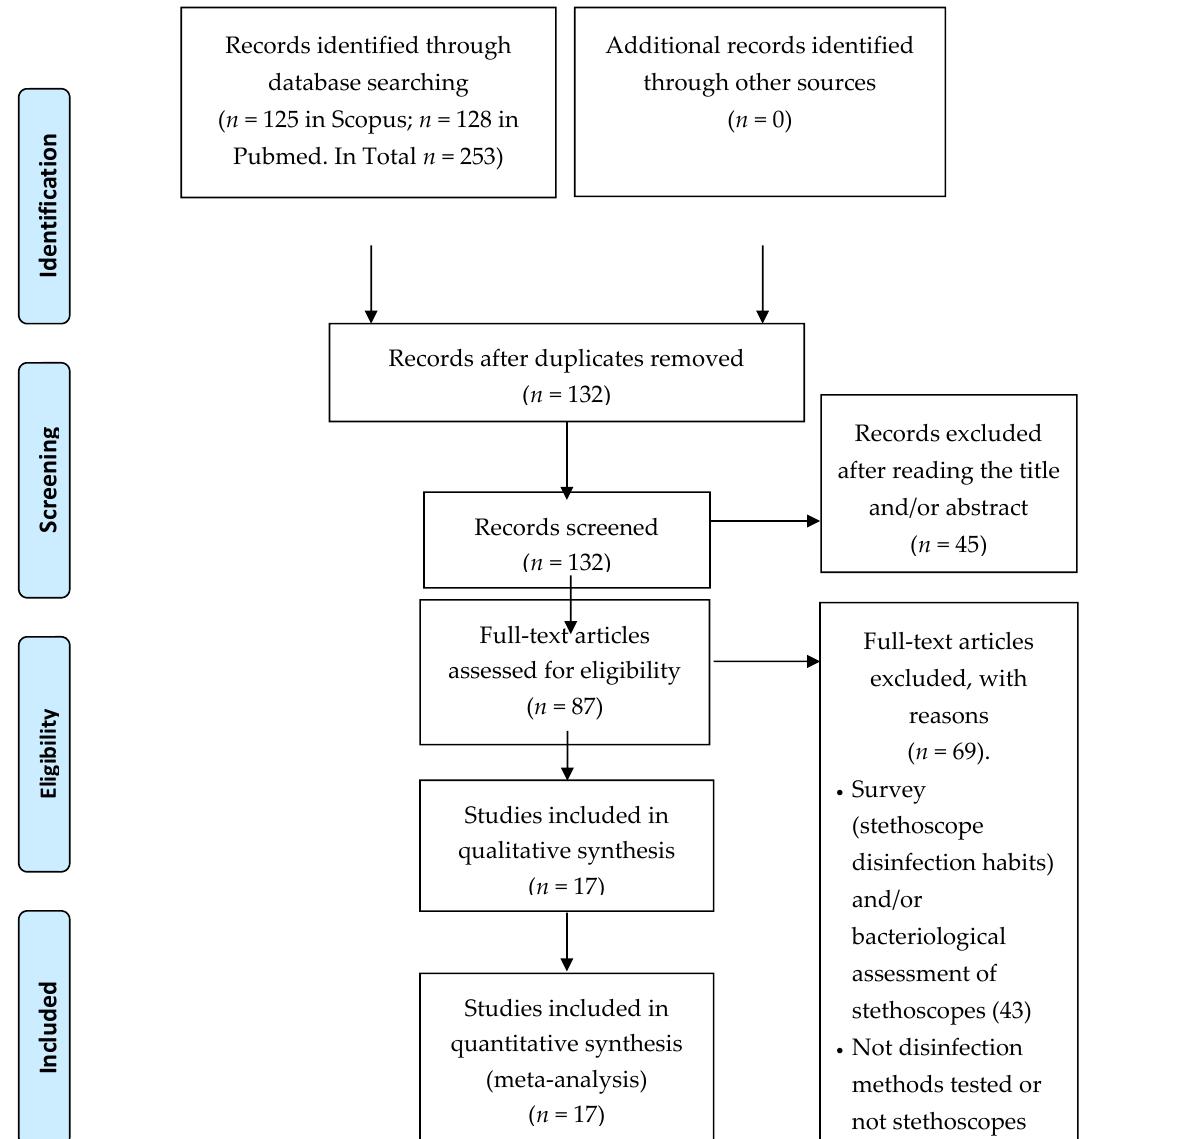
Figure 1. Preferred Reporting Items for Systematic reviews and Meta-Analyses (PRISMA) 2009 Flow diagram illustrating the process of selection of the eligible articles used in this paper.